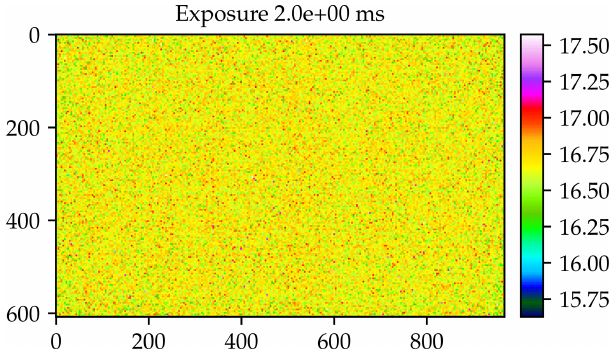
Figure 4. HaloCam RAW dark signal (in DN) of the R channel, av- eraged over 100 images. An exposure time of t expos = 2 . 0ms was chosen and a temperature of 45 ◦ C was measured inside the camera.